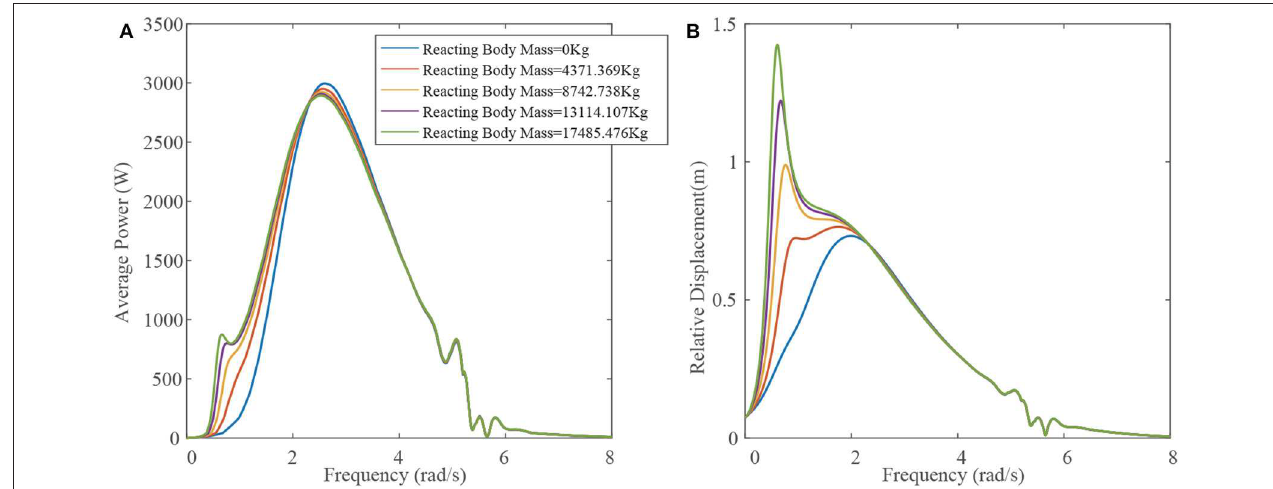
FIGURE 7 | Extracted average power (A) and relative displacement (B) vs. wave frequency at various reacting body masses.